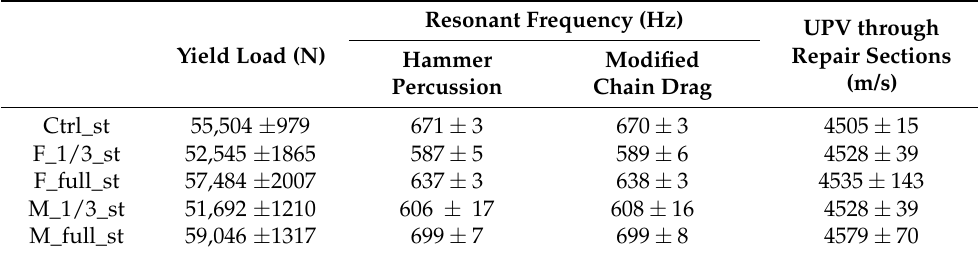
Figure 6. Load-center point deflection curve of beams with ( a ) 1/3 span repair ( b ) full-length repair ( c ) no repair. Table 6. Yield strength, bending stiffness, and NDT